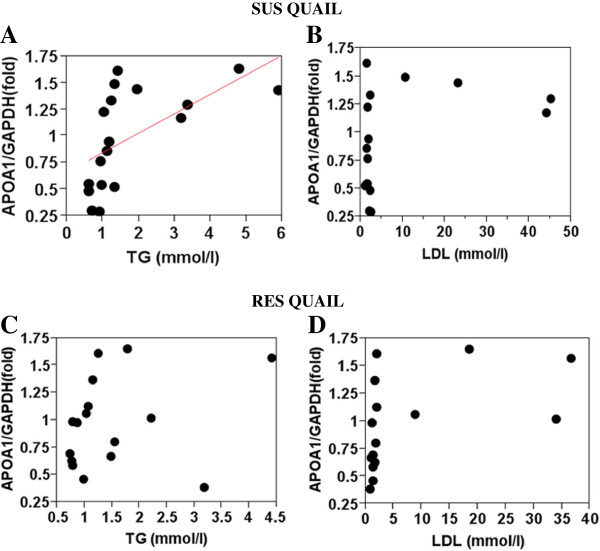
APOA1expression in SUS and RES liver relative to plasma triglyceride and LDL levels. In part A: r2 = +0.36; P < 0.009.